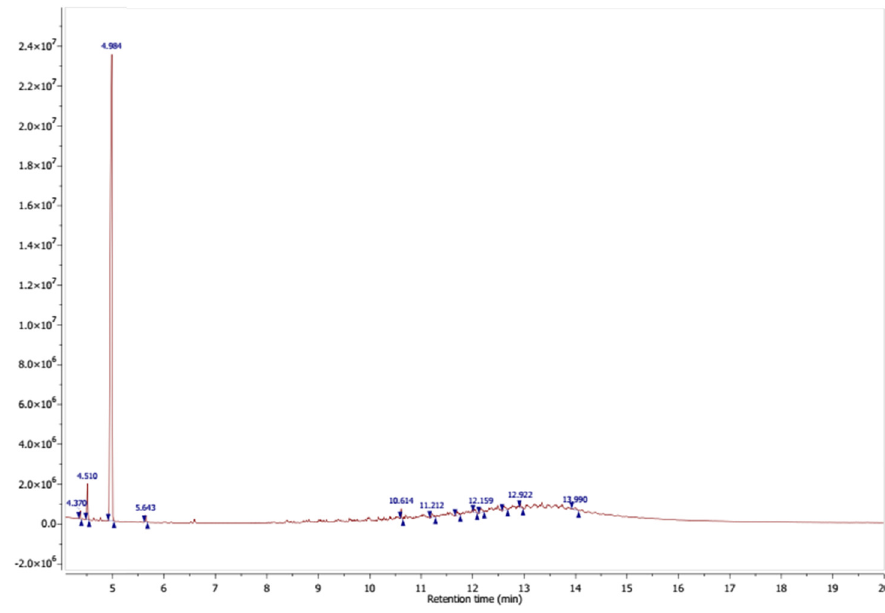
Figure 1: Chromatogram of the GC/MS identi fi ed compounds in C. sinensis